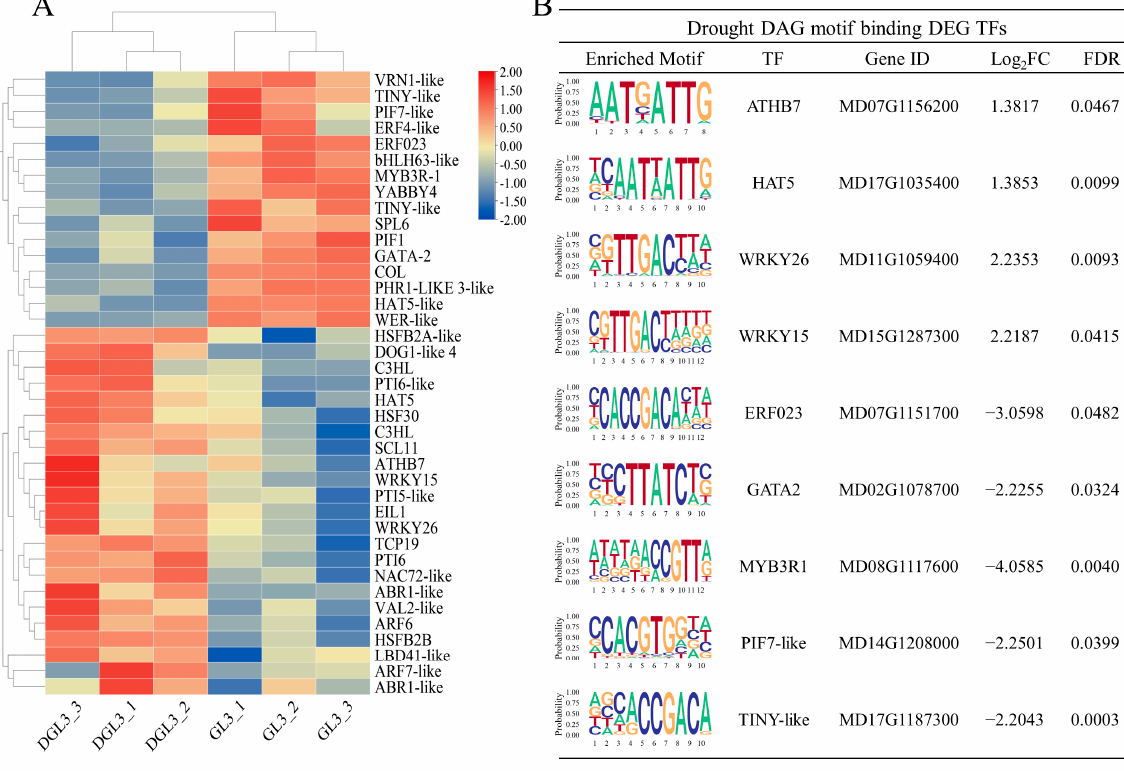
Figure 6. Differentially expressed transcription factors and differential ATAC signaling motif analysis. ( A ) Heatmap of the expression of differentially expressed transcription factors. ( B ) Differential ATAC signaling motif analysis enriched for differentially expressed transcription factors.